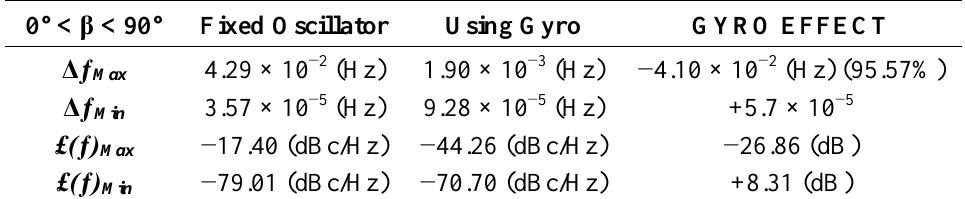
Figure 13. Comparison between steady state load-induced phase noise and Allan safety margin. ( a ) Fixed oscillator; ( b ) Gyroscopic mounting. Table 3. Analysis of gyroscopic mounting efficiency for crystal with |φ| = 2.6°.